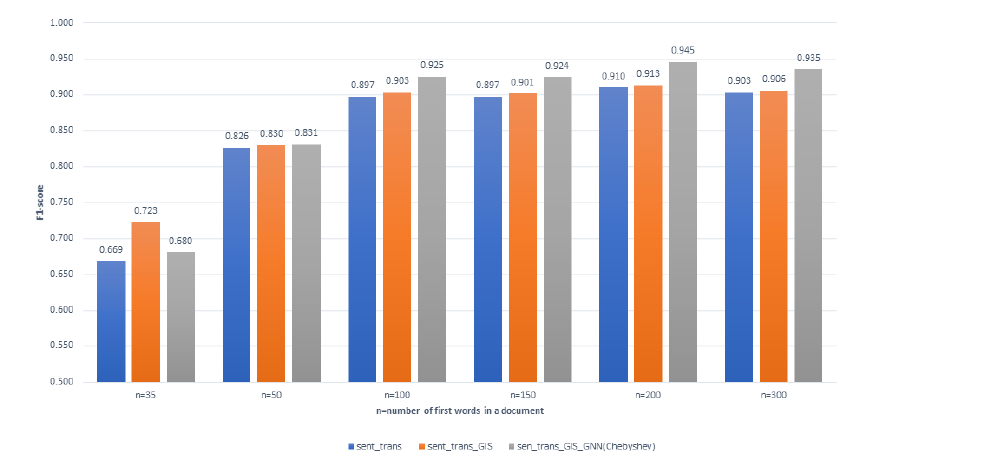
Figure 6. Comparison of F1-score for three different classification models for spatial